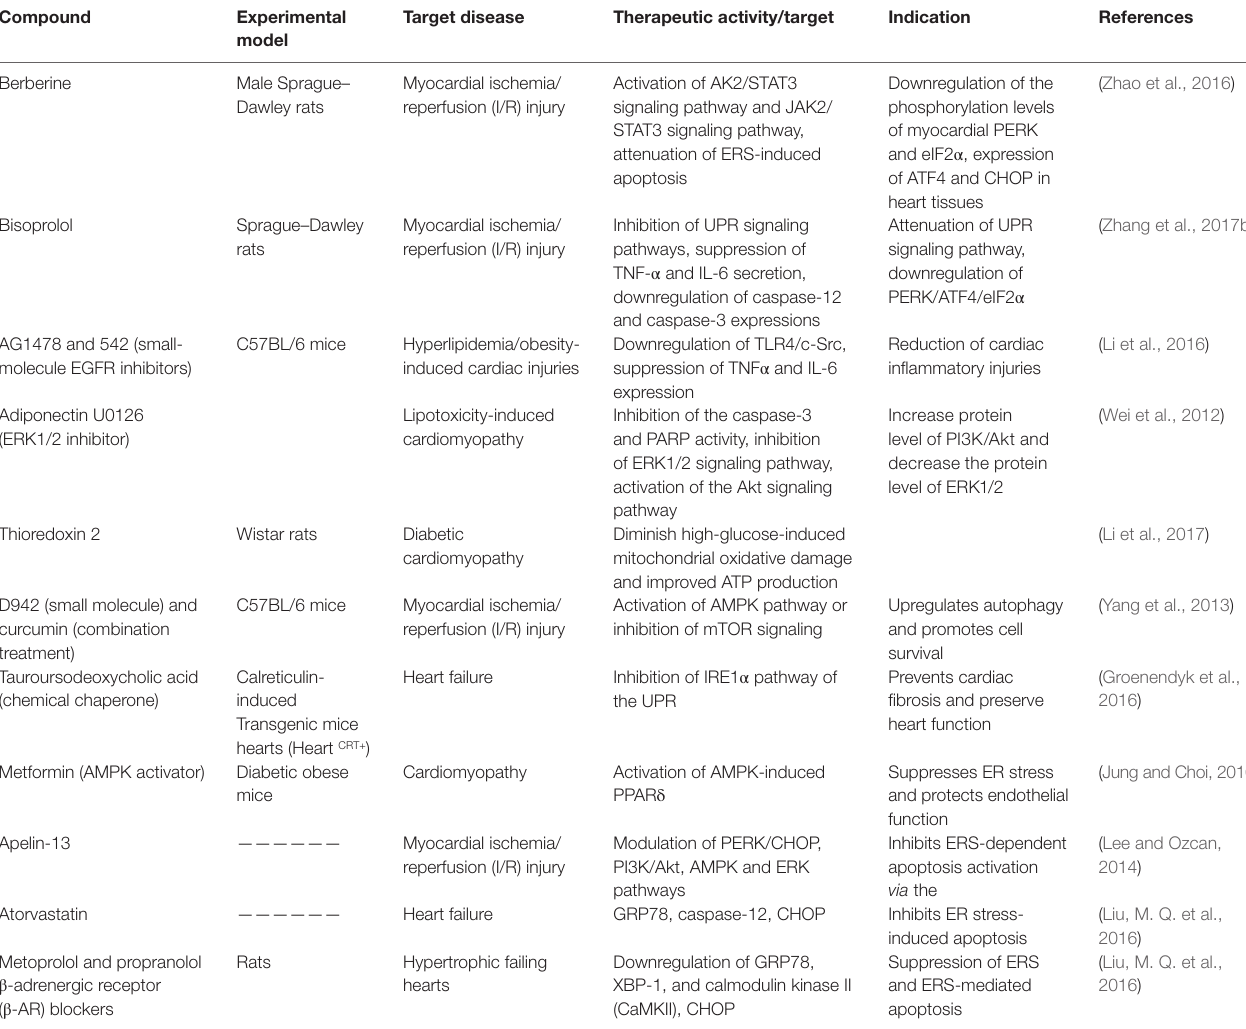
TABLE 3 | Preclinical therapeutics (natural compounds, small molecules, or peptides) targeting the UPR signaling pathway ( in vivo ).